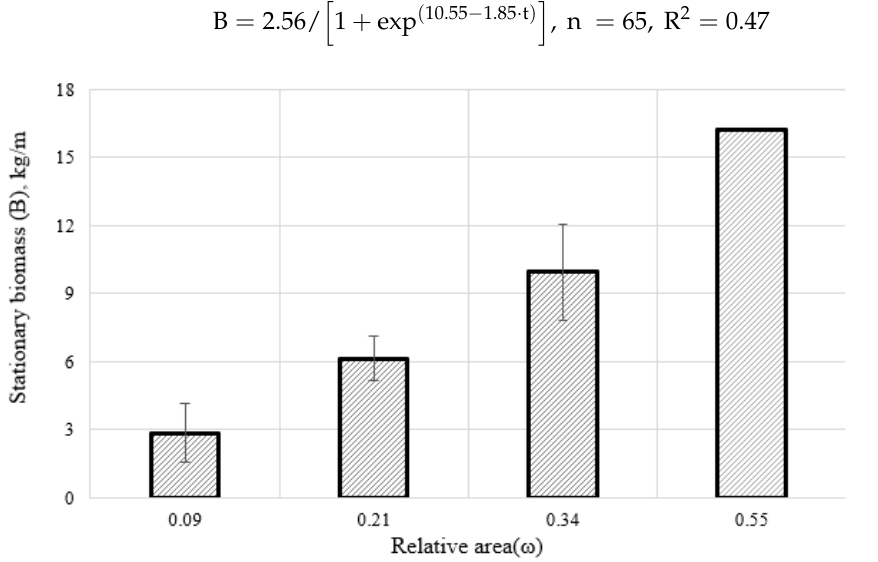
Figure 3. Relation between the stationary biomass (Bs) and the relative substrate area ( ω ) on different types of collectors; vertical lines are standard deviation.